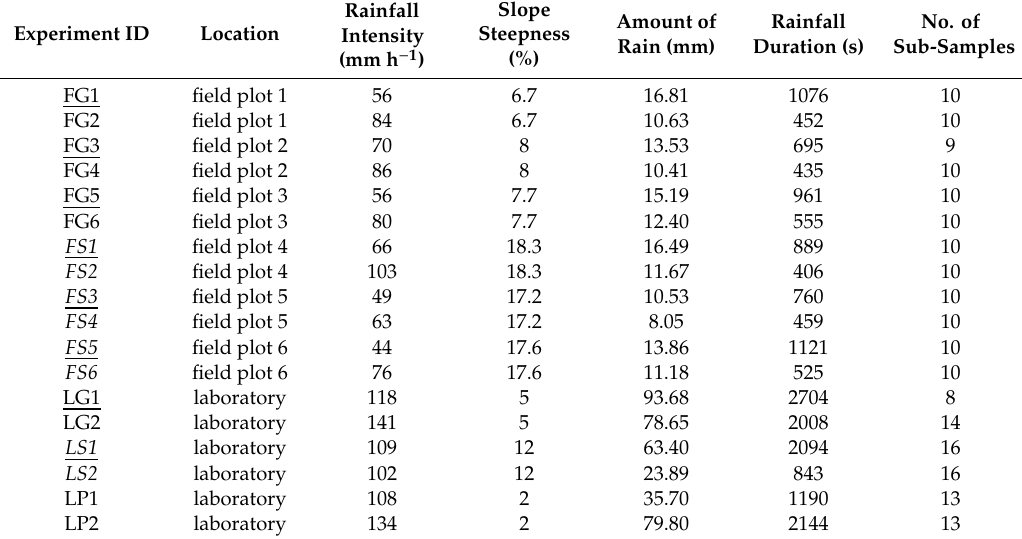
Table 2. Settings of the 18 laboratory and field rainfall simulation experiments. Identification (ID) code fields are as follows: F: field experiment, L: laboratory experiment; G: gentle slope, S: steep slope; P: plain (2% slope). Runs on steep slopes are in italics and runs under seedbed conditions are